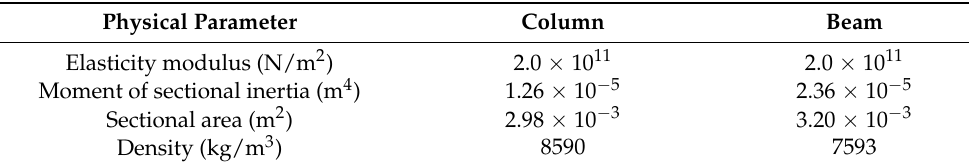
Figure 1. Finite element model of a rigid frame. Table 1. Physical parameters of rigid frame